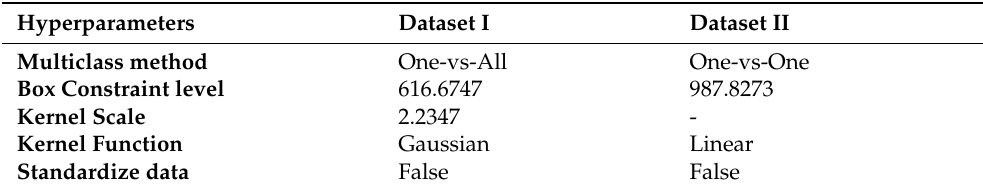
Table 2. Summary of hyperparameters used for datasets I and